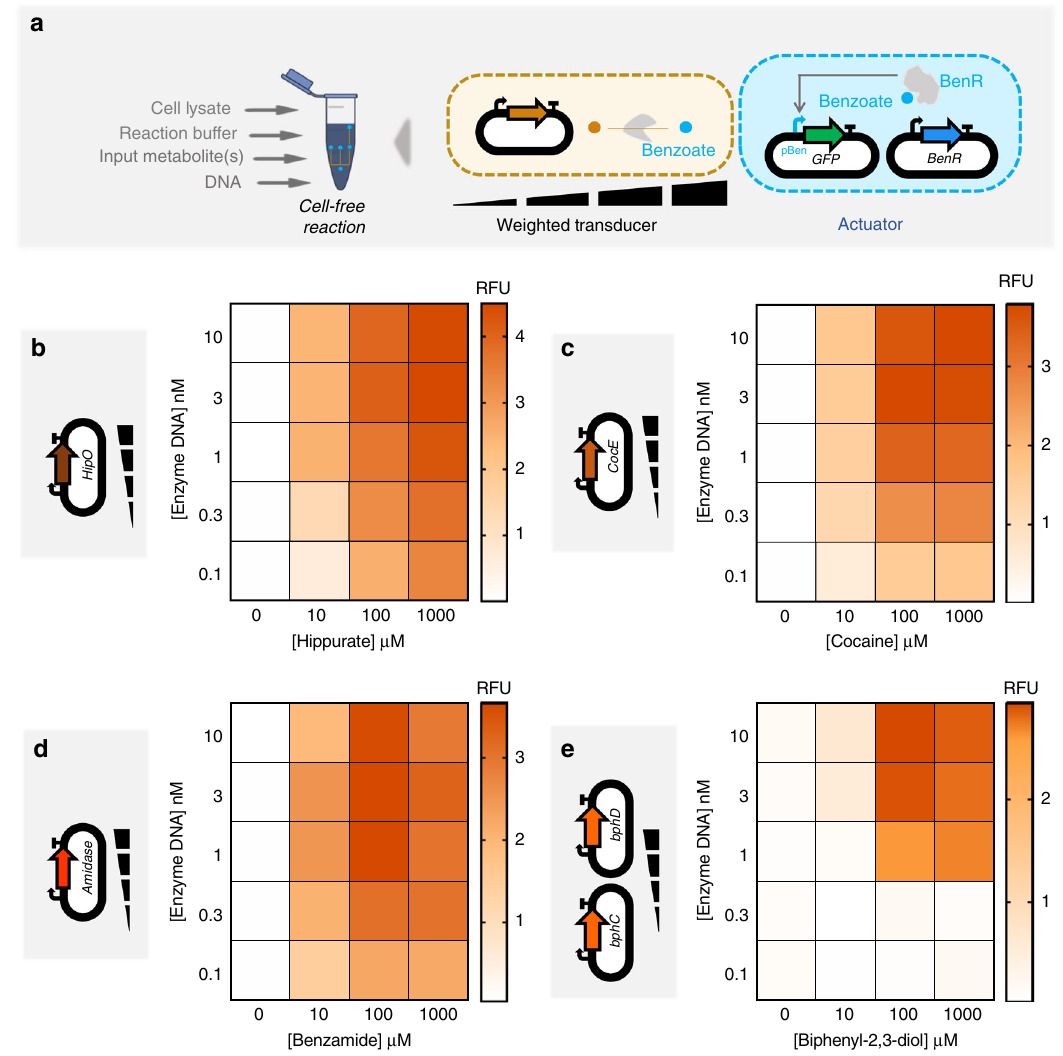
Fig. 4 Cell-free weighted transducers characterized by varying the concentration of the enzyme DNA. a In the cell-free system, the circuits can be tuned by varying the amount of each enzyme pipetted per reaction. Weighted transducers are characterized by varying the concentration of the enzymes in transducers which then are reported through the benzoate actuator. The range of the concentrations was varied to get optimal expression and minimum resource competition. b – e Heatmaps representing weighted transducers at different concentrations of input molecules and enzymes DNA for hippurate ( b ), cocaine ( c ), benzamide ( d ) and biphenyl-2,3-diol ( e ). For the biphenyl-2,3-diol weighted transducer ( e ), concentrations represent those of each metabolic plasmid (e.g., 1 nM of enzyme DNA refers to 1 nM of bphC plus 1 nM of bphD ). See Supplementary Fig. 9 for model results of each weighted transducer. All data are the mean of normalized values from three measurements. (RFU relative fl uorescence unit). Source data are provided in the